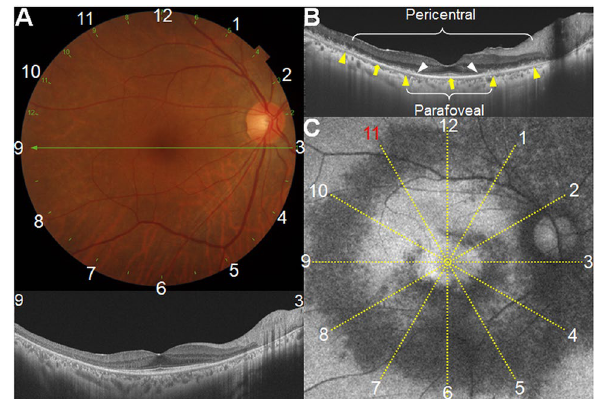
Figure 1. Representative images for evaluating clock-hour topography and outer retinal damage (white and yellow arrowheads) extent in eyes with hydroxychloroquine retinopathy. ( A ) Fundus photograph (top) showing the scanning area of the optical coherence tomography (OCT) scans used in this study (12-radial scan). Six radial intersecting line scans, each at 30-degree intervals, were used to scan each clock hour of the retina ( B ). ( C ) Fundus autofluorescence (FAF) images of an eye with severe hydroxychloroquine retinopathy of combined parafoveal and pericentral involvement. Compared to the relatively preserved retinal pigment epithelium (RPE) line (arrows), the parafoveal and pericentral areas showed thinning and attenuation of the RPE line (yellow arrowheads). FAF image of the eye merged with a 12-line grid radiating from the foveal center indicating ring-shaped parafoveal and pericentral lesions that spare only an 11 clock-hour area (red text) in the parafovea.